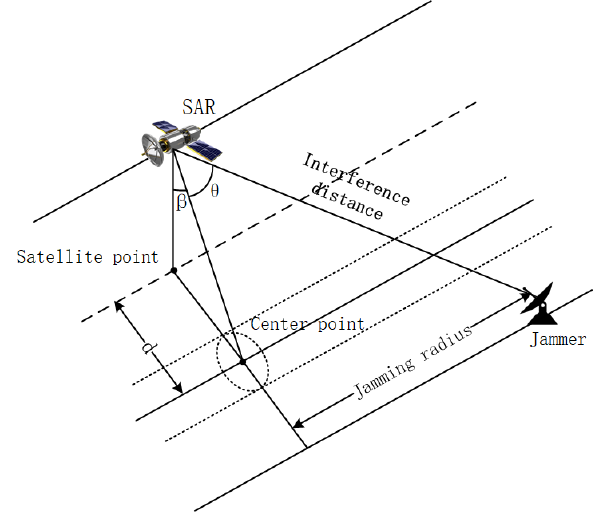
Figure 2. Imaging result of point